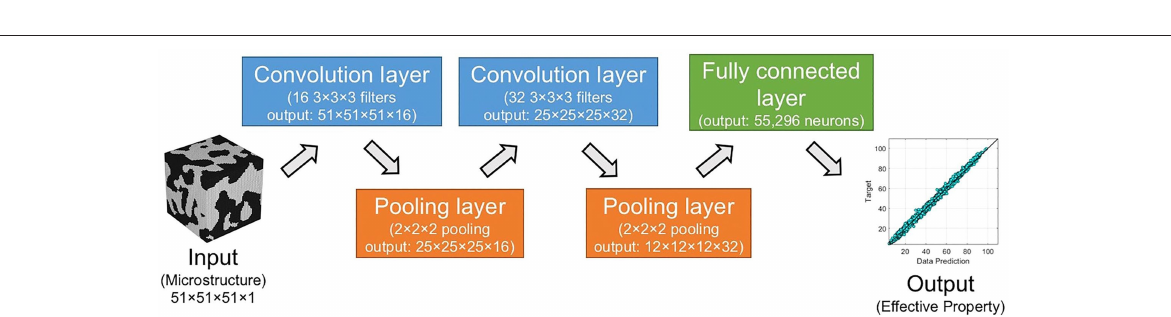
FIGURE 10 | Analysis of the interdependency in the nonlinear relationship of hardness ratio by variation of the input information. Top row left: using all inputs; top row right: omitting indentation depth to spherical indenter radius h / R ; bottom left: omitting mormalized Mises stress σ f /σ r ; bottom right: omitting normalized hydrostatic pressure p /σ r . Omitting an input is visible in a specific pattern of error in the predicted output.